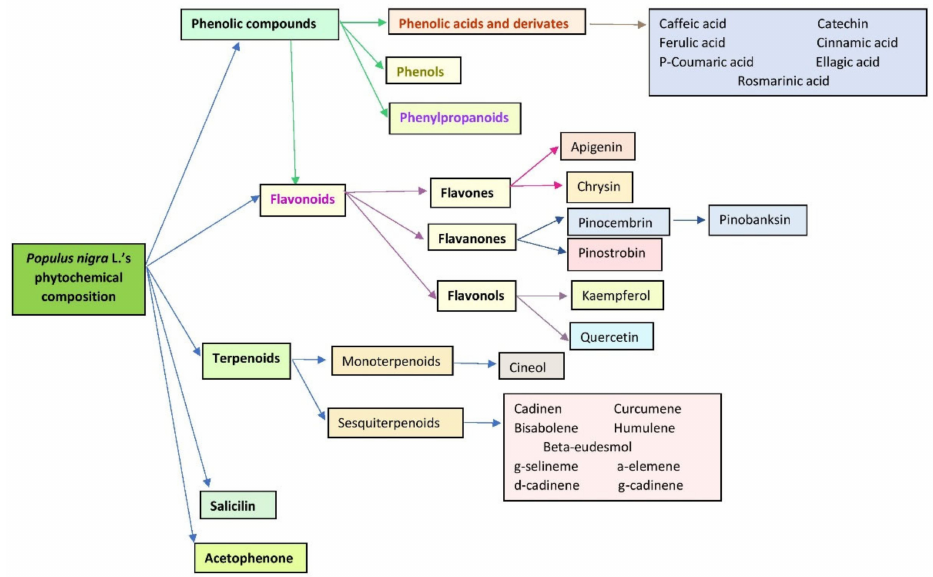
Figure 1. Main classes of phytochemicals in Populus nigra L.